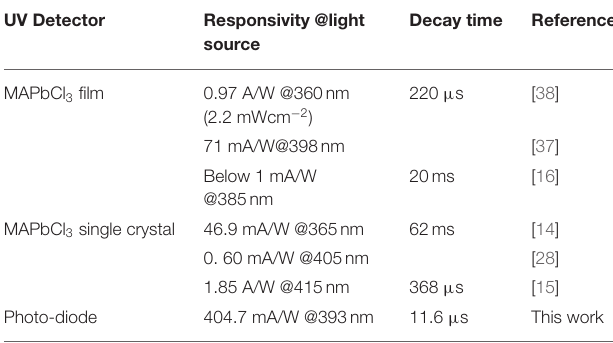
TABLE 1 | Comparison between this work and previously reported MAPbCl 3